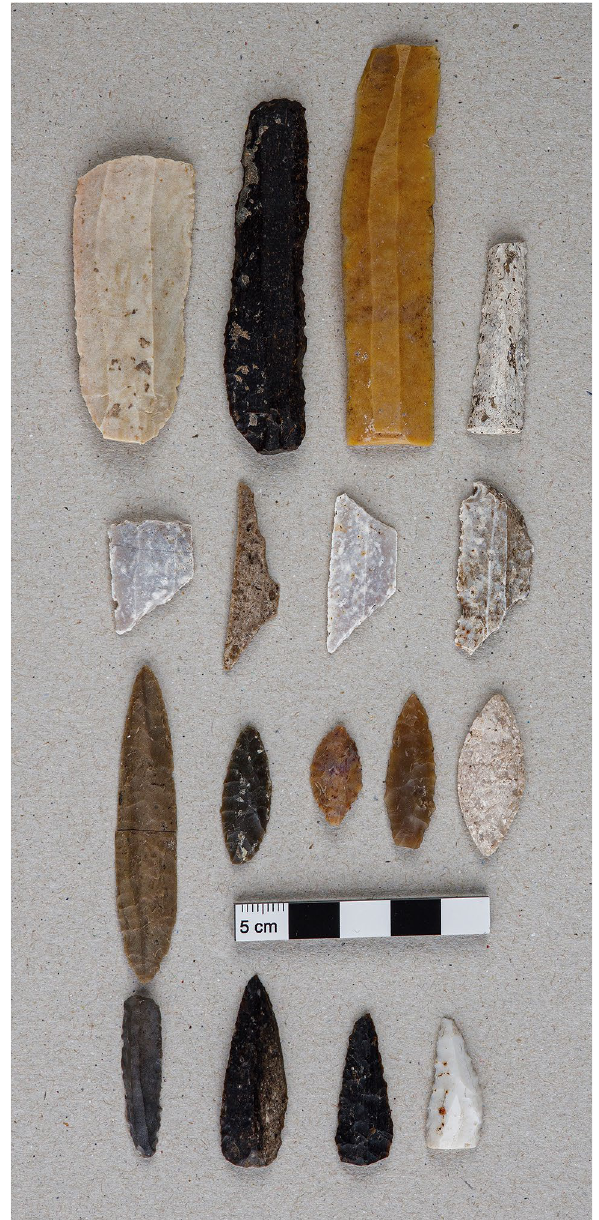
Figure 6. Selection of a set of flint lithic tools—blades, geometric microliths, and arrowheads—from the El Pendón ossuary. In the line below, four lithic tools that were submitted to a ’blind’ analysis by a specialist in traceology and use-wear analysis (Supplementary Text